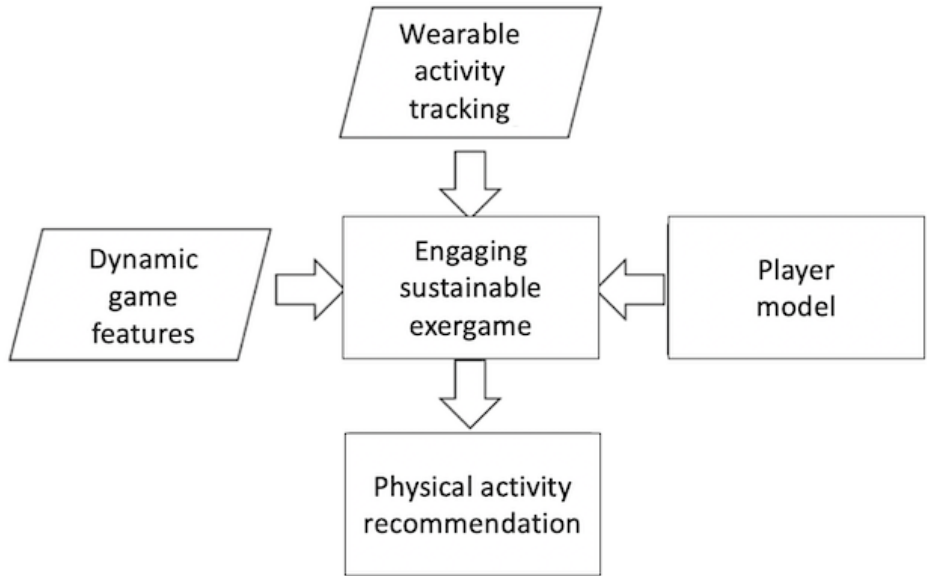
Figure 1. Conceptual model of the proposed system. Components surrounded by parallelograms were explored in our previous work, whereas components surrounded by rectangles are the aim of this research for personalizing physical activity recommendations. Arrows show the connection between the